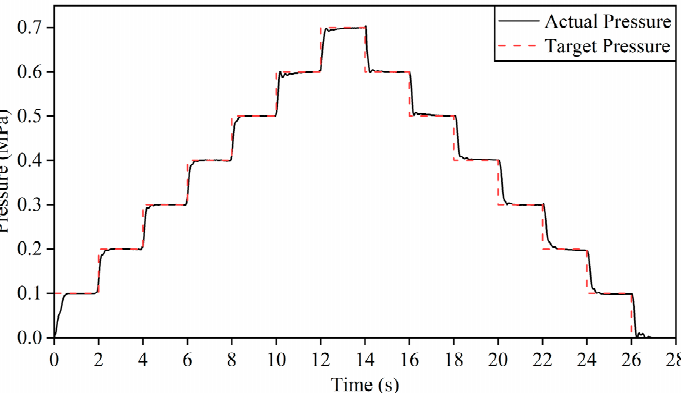
Figure 4. Dynamic pressure regulation performance of the pneumatic braking system.